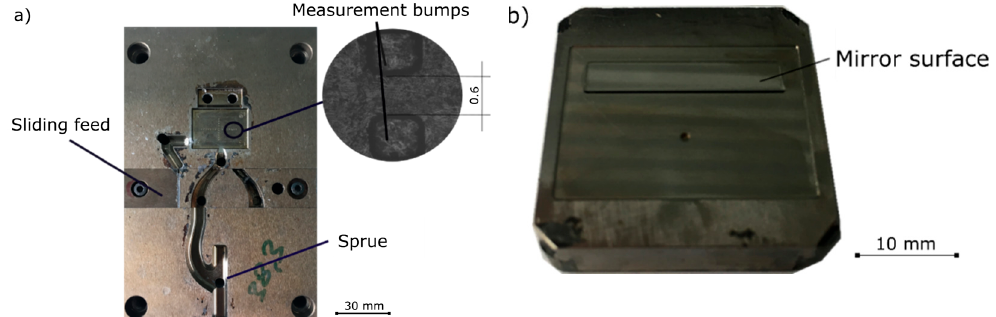
Figure 4. ( a ) measurement side of the cavity. Bumps for dimensional analysis were milled using precision machining. ( b ) mirror side of the cavity. The reflective surface was milled in NiP coating precision machining. ( b ): mirror side of the cavity. The reflective surface was milled in NiP coating using ultra-precision machining employing diamond mill bits. using ultra-precision machining employing diamond mill bits. Table 1. Parameters for the design of